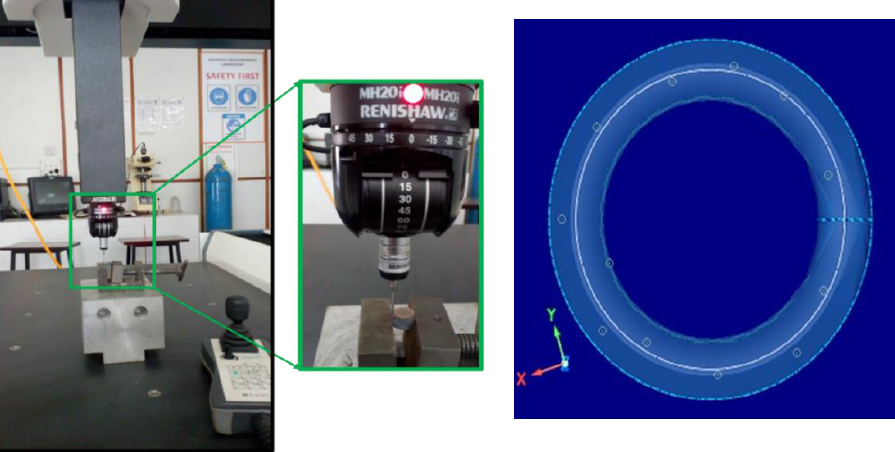
Figure 2. Measurement of out-of-roundness on a coordinate measuring machine (Courtesy: TIET, Patiala). The out-of-roundness value was recorded before and after machining for each